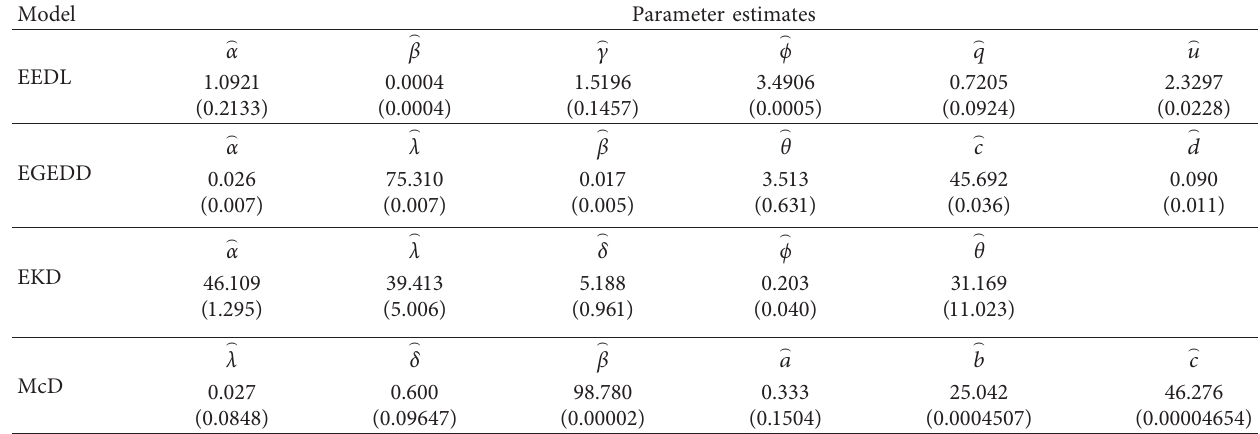
Figure 5: Failure time on yarn. Table 6: Maximum likelihood estimates of parameters and standard errors for yarn data.